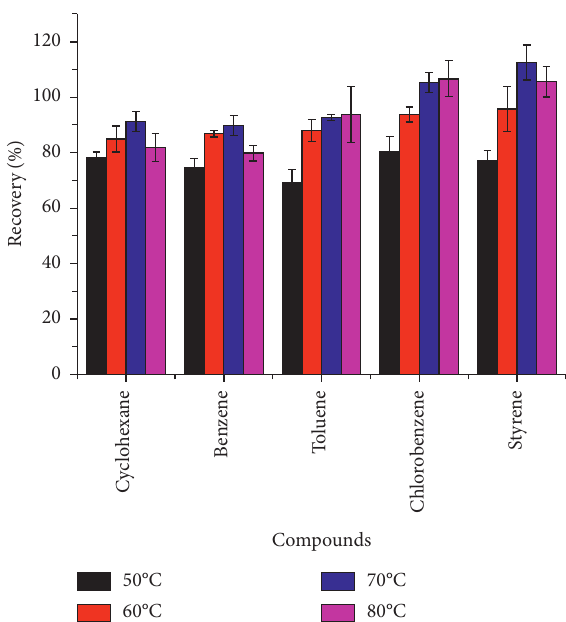
Figure 4: Effect of extraction temperature on extraction efficiency of soy